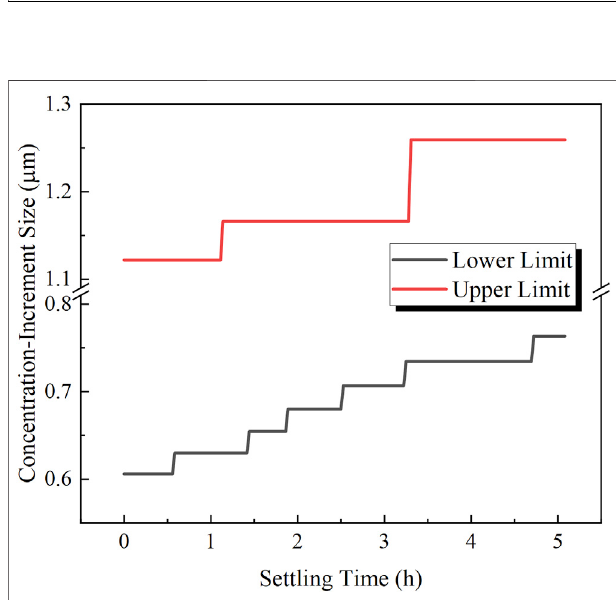
FIGURE 12 | Size distribution of the relative removal rate due to gravitational deposition and coagulation.